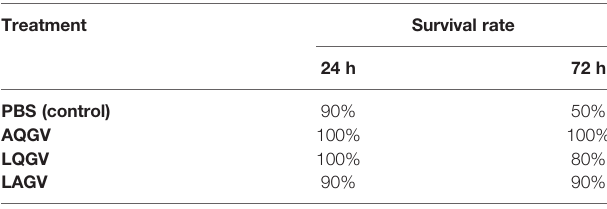
TABLE 4 | Effects of various oligopeptides (5 mg/kg) related to hCG- b on the survival rate of mice subjected to ischemia-reperfusion damage. Treatment Survival